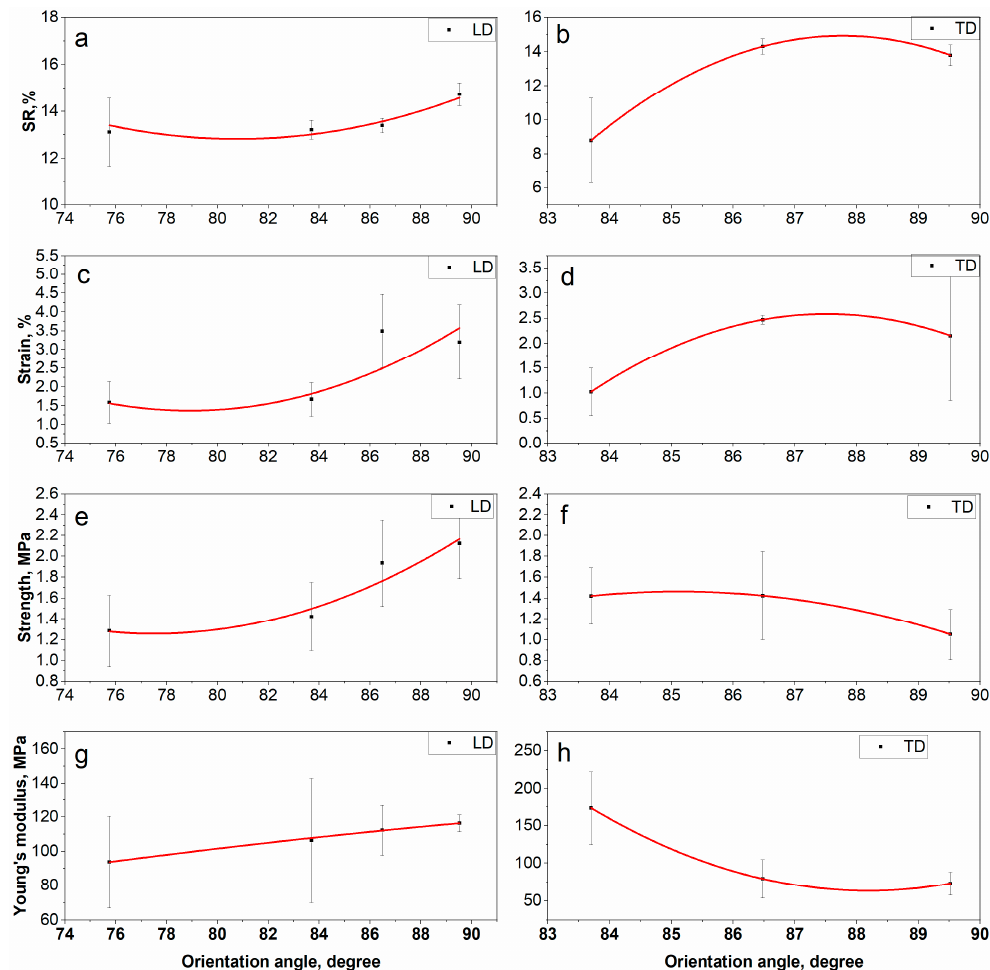
Figure 8. Shrinkage ratio and mechanical properties–orientation angle diagrams. (a) Shrinkage ratio in the LD of the collector–orientation angle; (b) Shrinkage ratio in the TD of the collector–orientation angle; (c) Strain in the LD of the collector–orientation angle; (d) Strain in the TD of the collector–orientation angle; (e) Strength in the LD of the collector–orientation angle; (f) Strength in the TD of the collector–orientation angle; (g) Young's modulus in the LD of the collector–orientation angle; (h) Young's modulus in the TD of the collector–orientation angle.